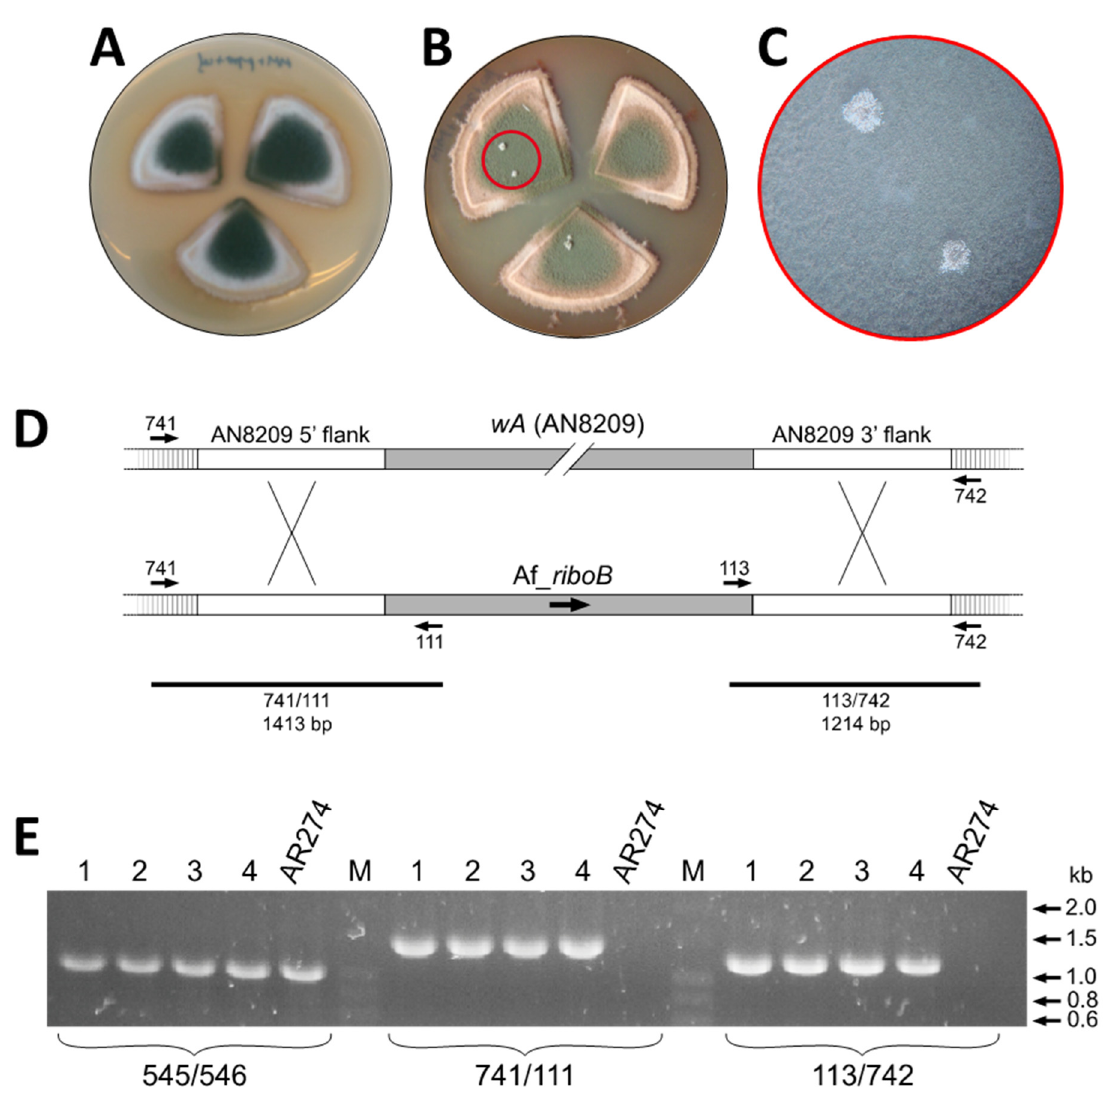
Figure 4. Integration of Af_ riboB in the wA locus. ( A ) Growth of AR198 on MM plates supplemented with pyridoxine but lacking riboflavin. ( B ) Late appearance of white colonies on MM plates lacking riboflavin. ( C ) Approximately 20 × magnification of the red-circled area in ( B ). ( D ) Scheme showing insertion of the Af_ riboB expression cassette in wA . ( E ) Diagnostic PCR with primer pairs 741/111 and 113/742 yielded fragments of the sizes predicted for insertion of Af_ riboB in the wA locus. Numbers refer to the four independent transformants analysed.